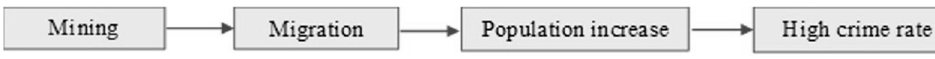
Figure 3. A diagram illustrating the connection between mining and high crime rates.